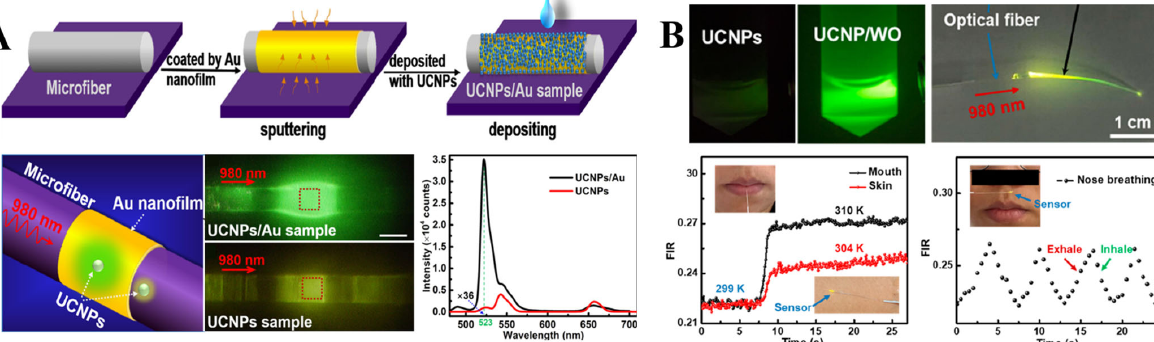
Figure 6. ( A ) Illustration of the selective plasmon-enhanced green emission upconversion nanoprobe for temperature sensing, which include: schematics of the fabrication process, optical images of the sensor upon laser excitation and comparative illustration of the upconversion photoluminescence enhancement induced by Au nanofilm. Reprinted with permission from reference [83]. ( B ) Optical images of UCNPs and UCNPs/WO solutions under a 980 nm laser illumination. Fluorescence intensity ratio changes from the air to the mouth (black line), hand skin (red line) and time‐dependent breath sensor response (dotted line). Reprinted with permission from reference [84].